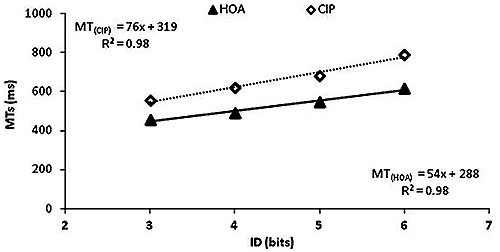
Efficiency functions in both groups. Efficiency functions of cognitively impaired patients (CIP; open diamonds) showed a larger slope than that of healthy older adults (HOA; black triangles).